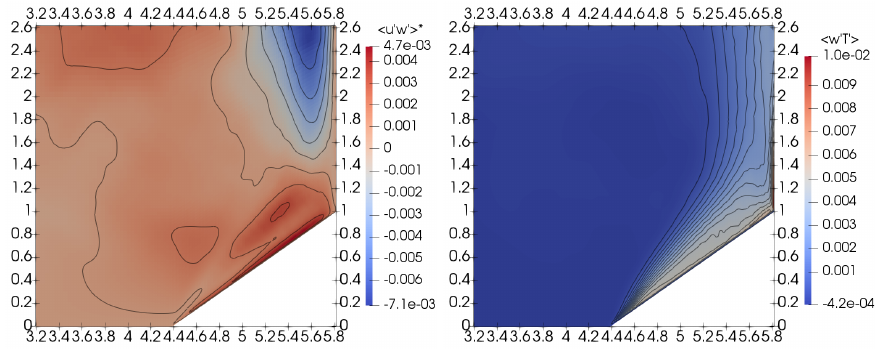
Figure 8. Turbulent kinematic momentum flux (cid:104) u (cid:48) w (cid:48) (cid:105) and vertical heat flux (cid:104) w (cid:48) T (cid:48) (cid:105) made non- dimensional and averaged. Distribution at a vertical plane, normal to the spanwise direction and reduced to the observation